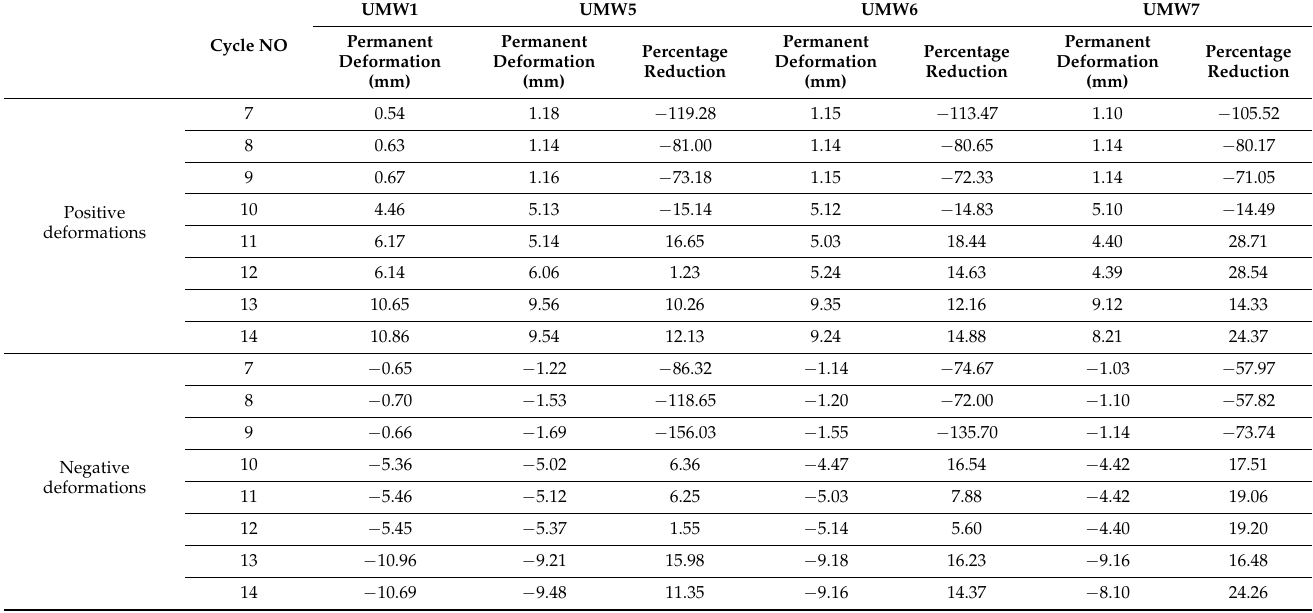
Table 4. Permanent deformation of the cross-strip